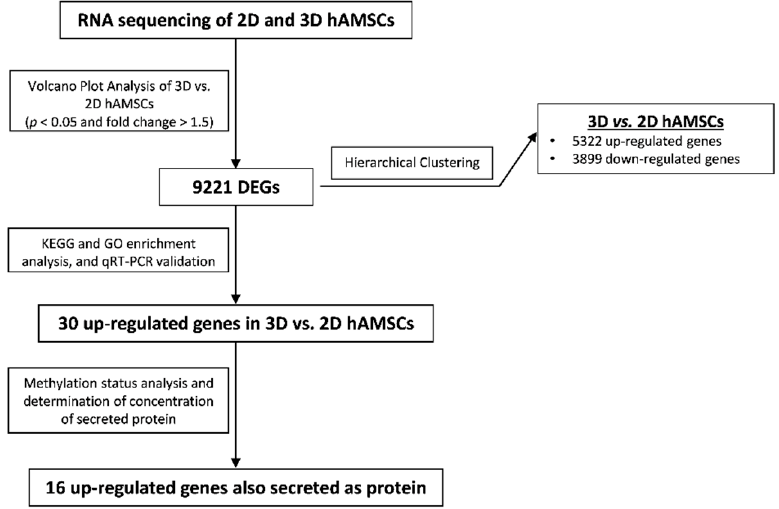
Figure 6. Gene screening process. Data analysis workflow in both 2D and 3D hAMSCs.